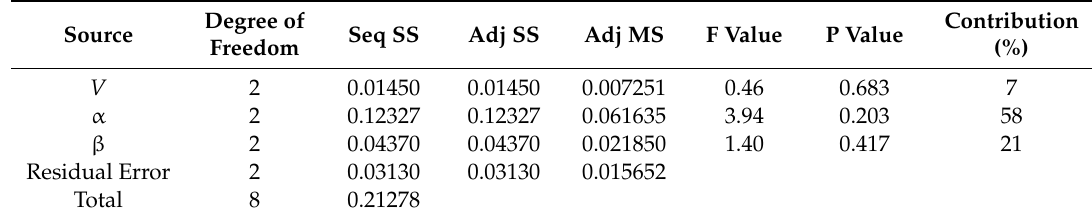
Table 4. Analysis of variance for